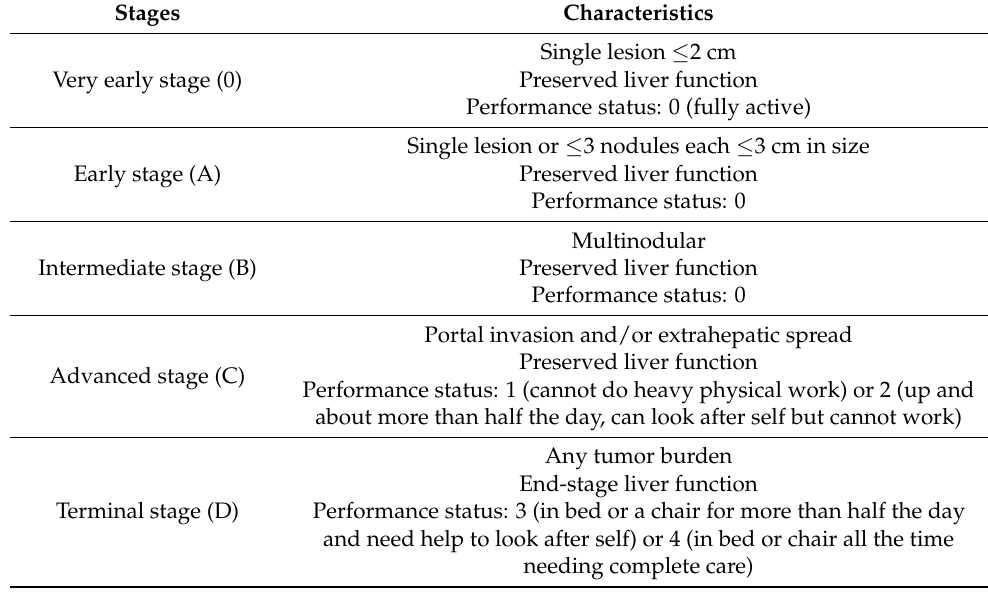
Table 1. Barcelona clinic liver cancer classification for the prognosis and treatment of hepatocellular carcinoma [5].